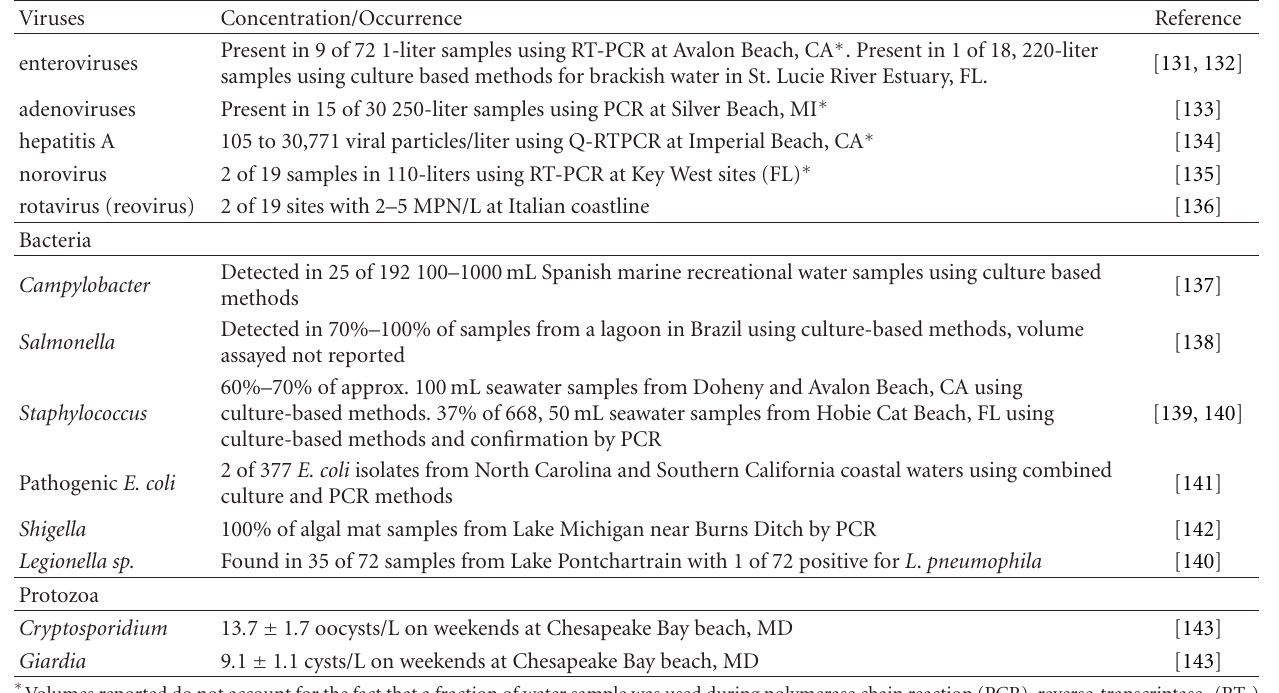
Table 1: Examples of allothchonous human pathogens detected in coastal